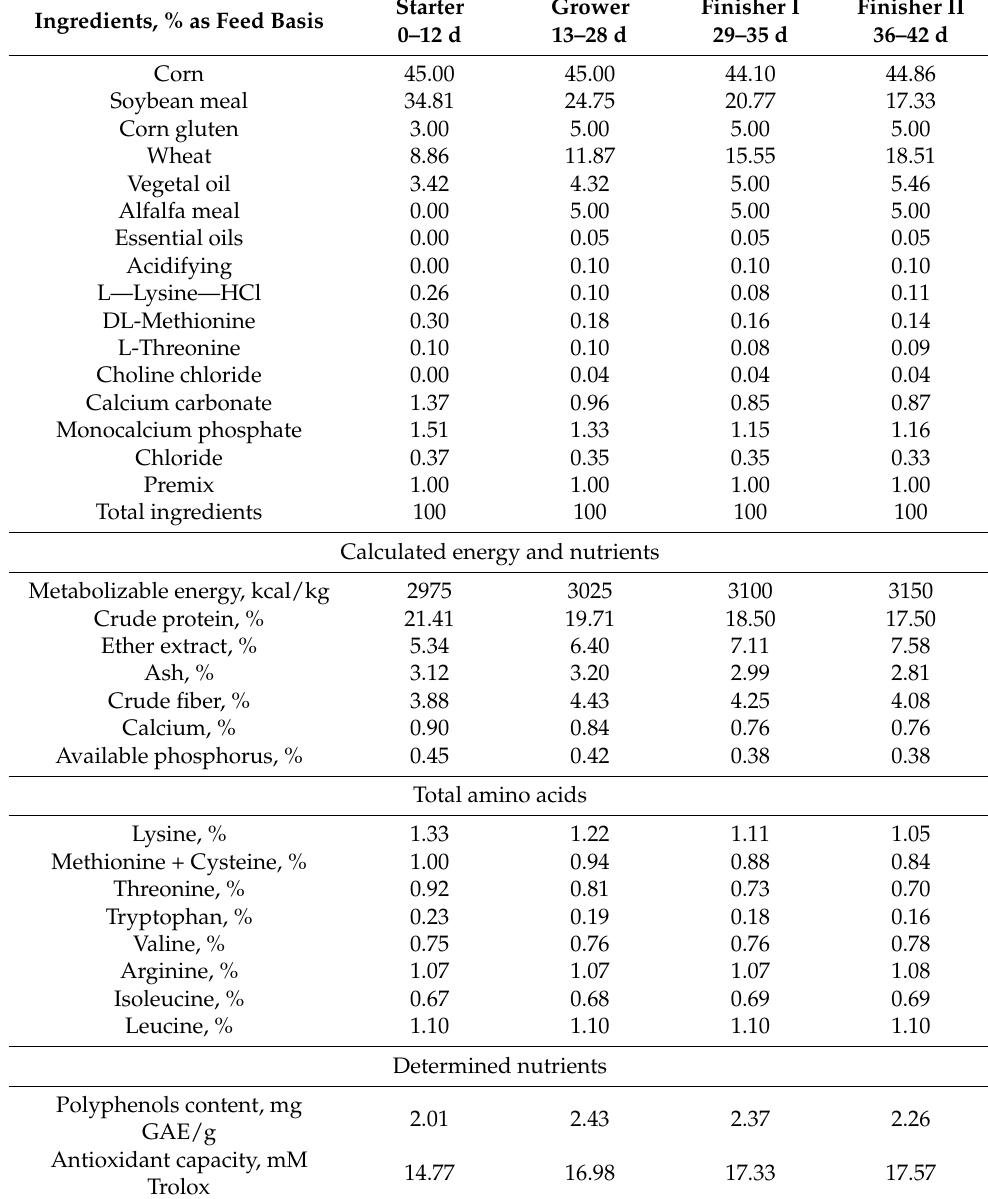
Table 1. Experimental diets of starter, grower and finisher phases given to the broiler chickens for 42 days. Ingredients, % as Feed